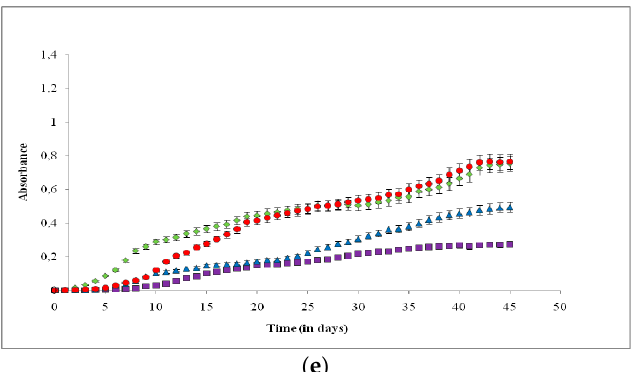
Figure 1. Growth curves of the five microalgae species: C. vulgaris ( a ), B. braunii ( b ), C. reinhardtii ( c ), N. oculata ( d ), and E. gracilis ( e ) in the four different environmental conditions. Red circles: March, Blue triangles: Controlled environment of growth chamber, Purple squares: October, Green diamonds: June. The error bars represent the standard deviation of the means. Table 1. Mean daily (and standard deviation) irradiation (I in MJ m − 2 day − 1 ), temperature of the cultivation media (T in ◦ C), specific growth rates in exponential growth phase ( µ exp in d − 1 ), and biomass productions (P b in g L − 1 ) for the five microalgae species cultivated in the four different environmental conditions.